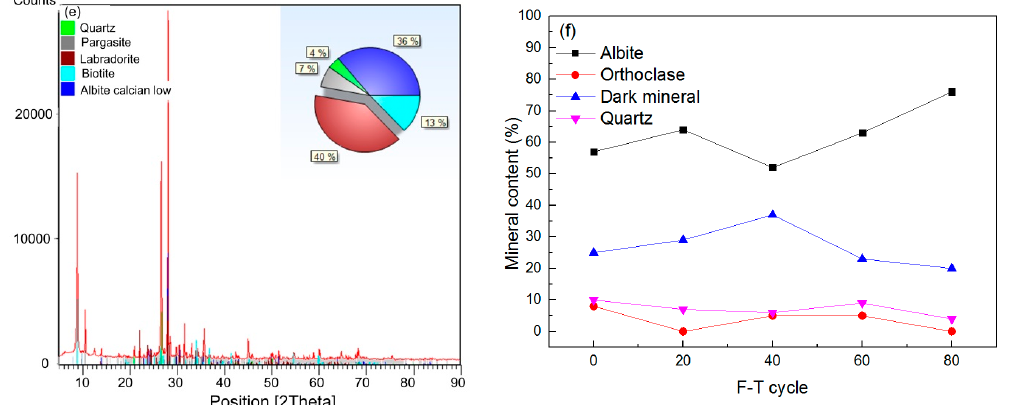
Figure 8. XRD results ( a – e ); the numbers of F–T cycles are 0, 20, 40, 60 and 80, respectively; ( f ) the main mineral content changes at different F–T